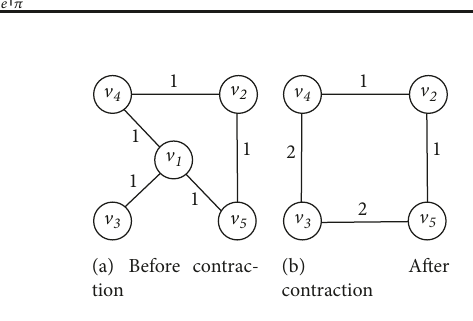
Figure 2: Contraction of